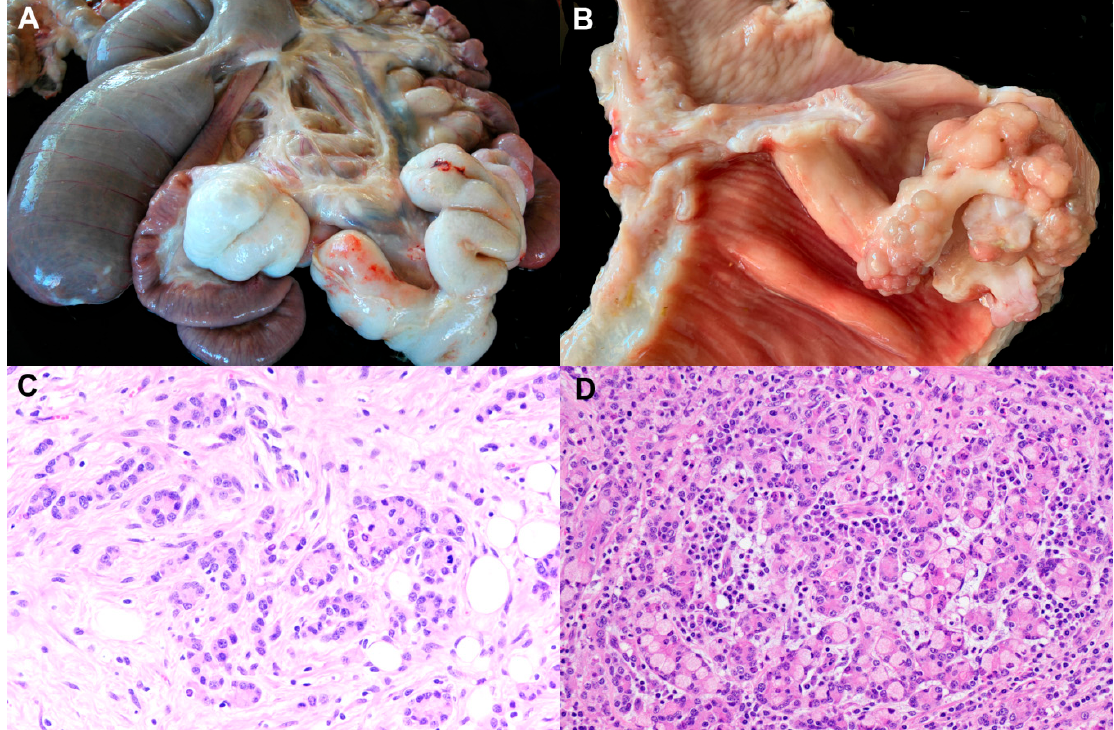
Figure 1. Gross pathology and histopathology of the small intestinal adenocarcinoma. ( A ) Sheep 5 years old. Serous surface on distal third segment of the small intestine. Firm and white mass extending over serosa of convoluted intestinal segment. Plaited whitish cords are extended on the mesentery. ( B ) Sheep 5 years old. Section of the intestine showing single polypoid pedunculated mass causing stricture. Lumen of the intestine greatly dilated is observed proximal to the mass. ( C ) Histopathology of an intestinal sample from A. Acinar and tubular structures of various sizes lined by cuboidal or columnar epithelial cells replace the intestinal mucosa. Small groups or cords of epithelial cells are also seen. Moderate desmoplastic reaction together with lymphocyte infiltration is observed. Hematoxylin ‐ eosin. 200×. ( D ) Histopathology of an intestinal sample from B. Signet ring cells characterized by mucin ‐ filled cytoplasm; peripheralized crescent ‐ shaped nuclei are numerous in this area of the tumour. Hematoxylin ‐ eosin. 100×.